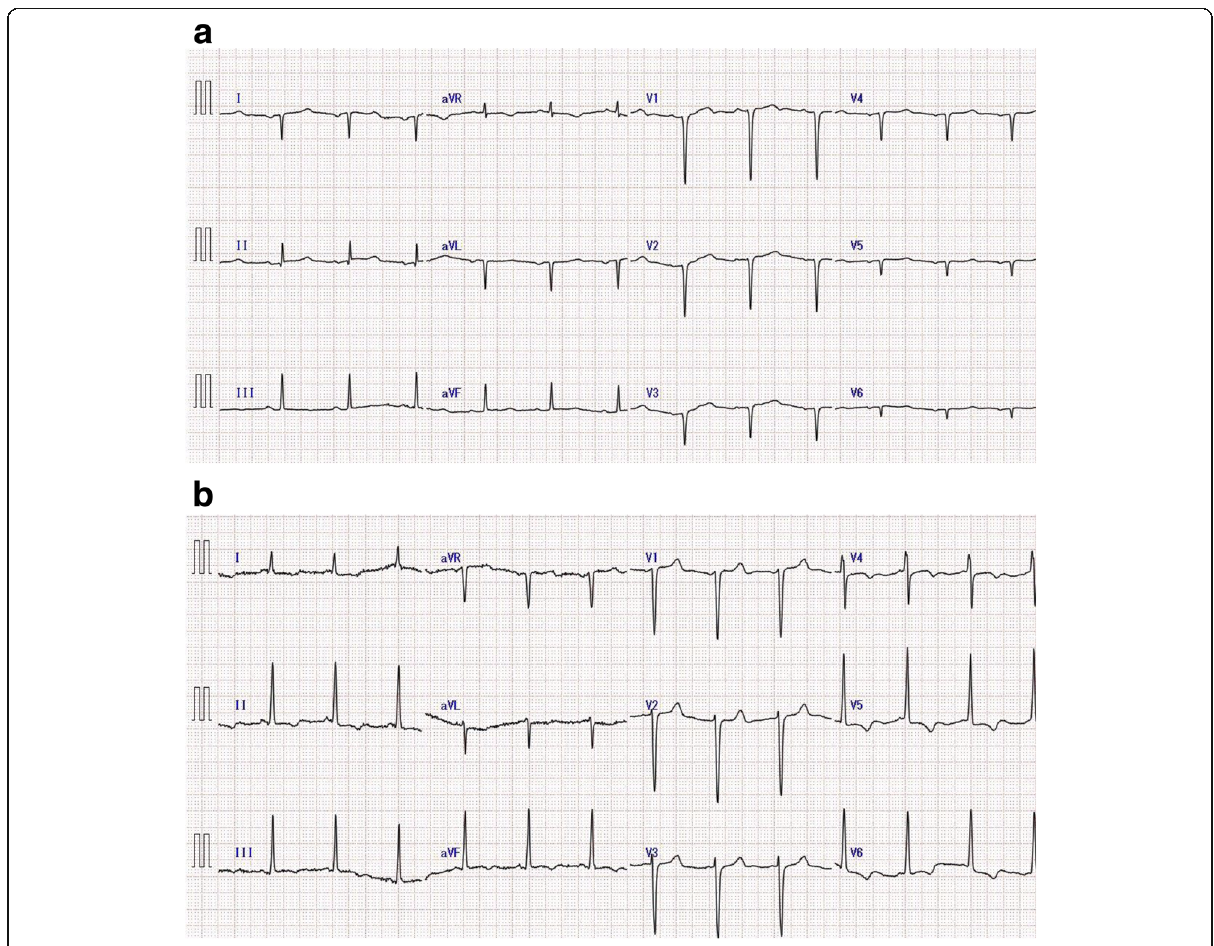
Fig. 1 a Preoperative electrocardiogram conducted with chest leads in their normal positions. The P wave is negative in the I and aVL leads and positive in the aVR lead. b Preoperative ECG conducted with the placement of the right lead reversed showed ST depression in the I and aVL, V5, and V6 leads, and negative T wave in the II, III, aVf, and V4 – 6